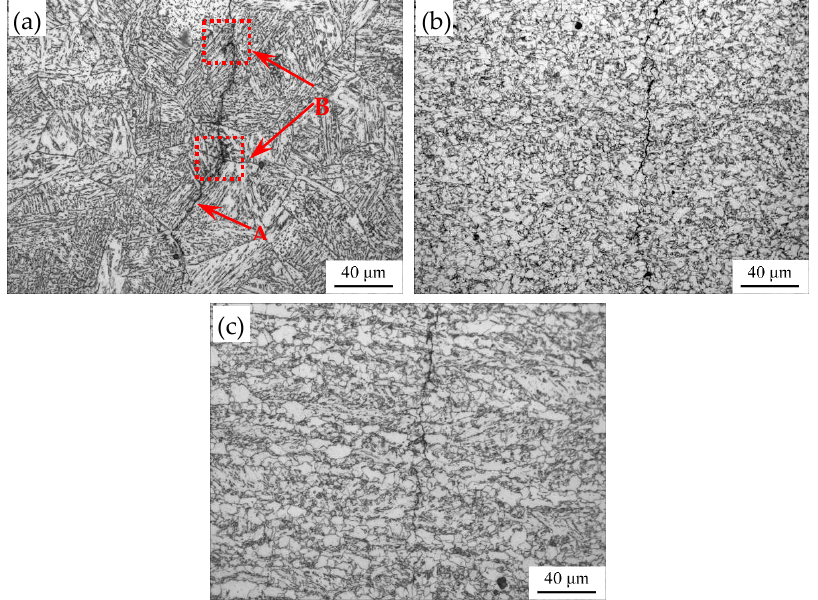
Figure 10. Typical OM micrographs of the fatigue crack path ( a ) 1350 °C; ( b ) 1050 °C; ( c ) 850 °C.